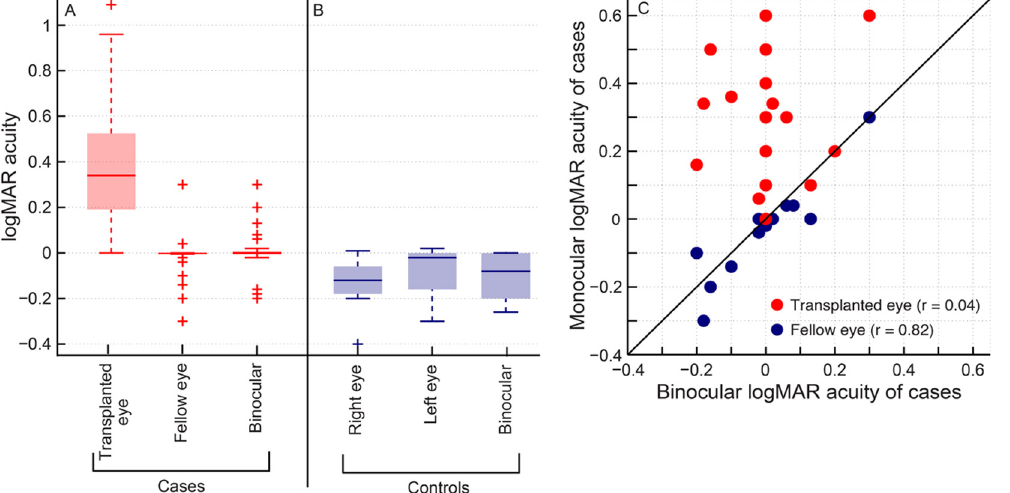
Fig 3. Monocular and binocular high-contrast logMAR acuity of cases (panel A) and controls (panel B) that participated in this study. Details of Box and Whisker plot same as Fig 1. Scatter diagram of monocular logMAR acuity of cases from the transplanted eye and the healthy fellow eye plotted against their corresponding binocular logMAR acuity (panel C). Correlation coefficient between binocular and the respective monocular logMAR acuities are shown in parenthesis in this panel.